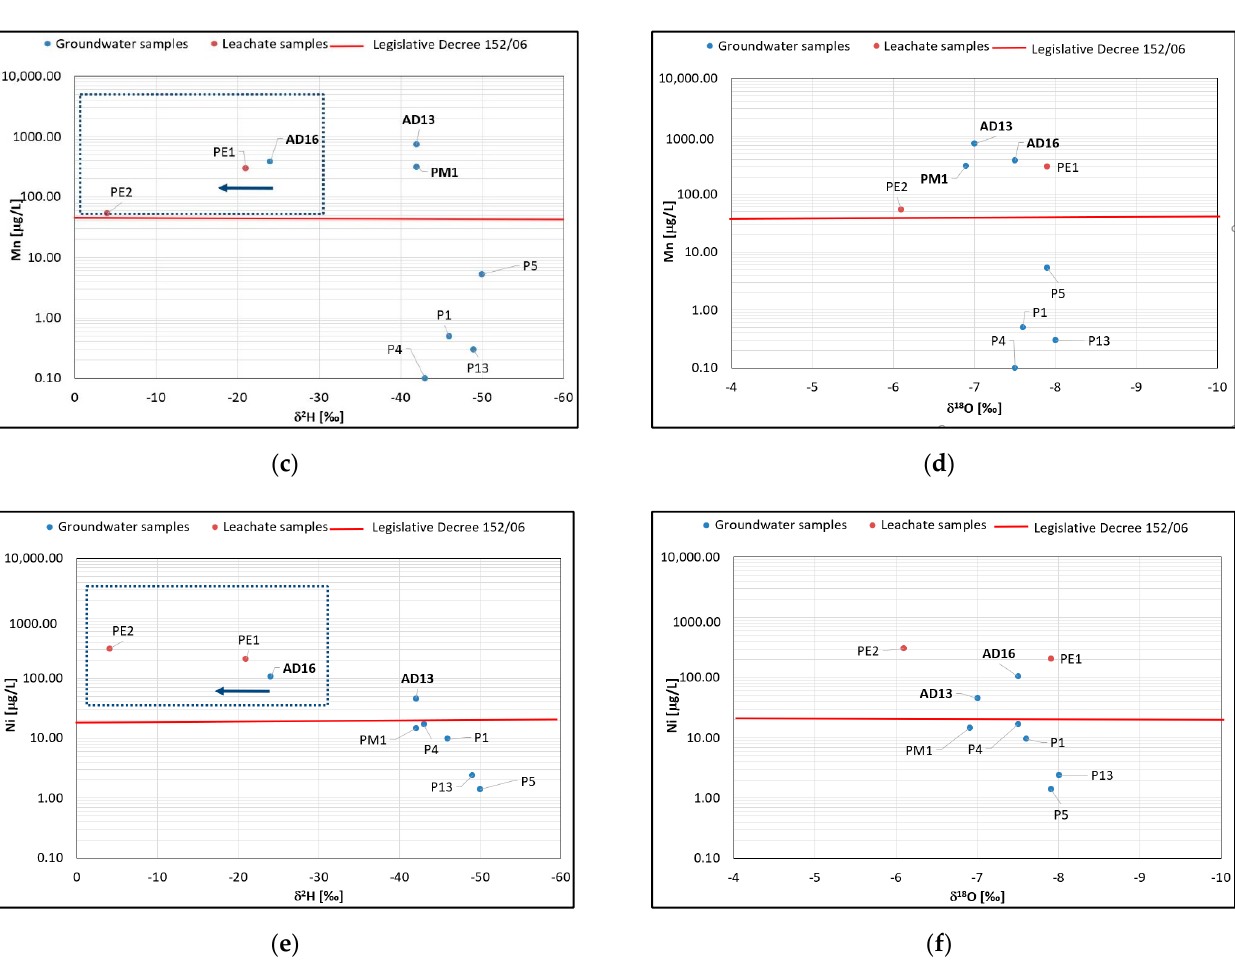
Figure 9. Scatter plot ( a ) Fe and δ 2 H, ( b ) Fe and δ 18 O, ( c ) Mn and δ 2 H, ( d ) Mn and δ 18 O, ( e ) Ni and δ 2 H and ( f ) Ni and δ 18 O .